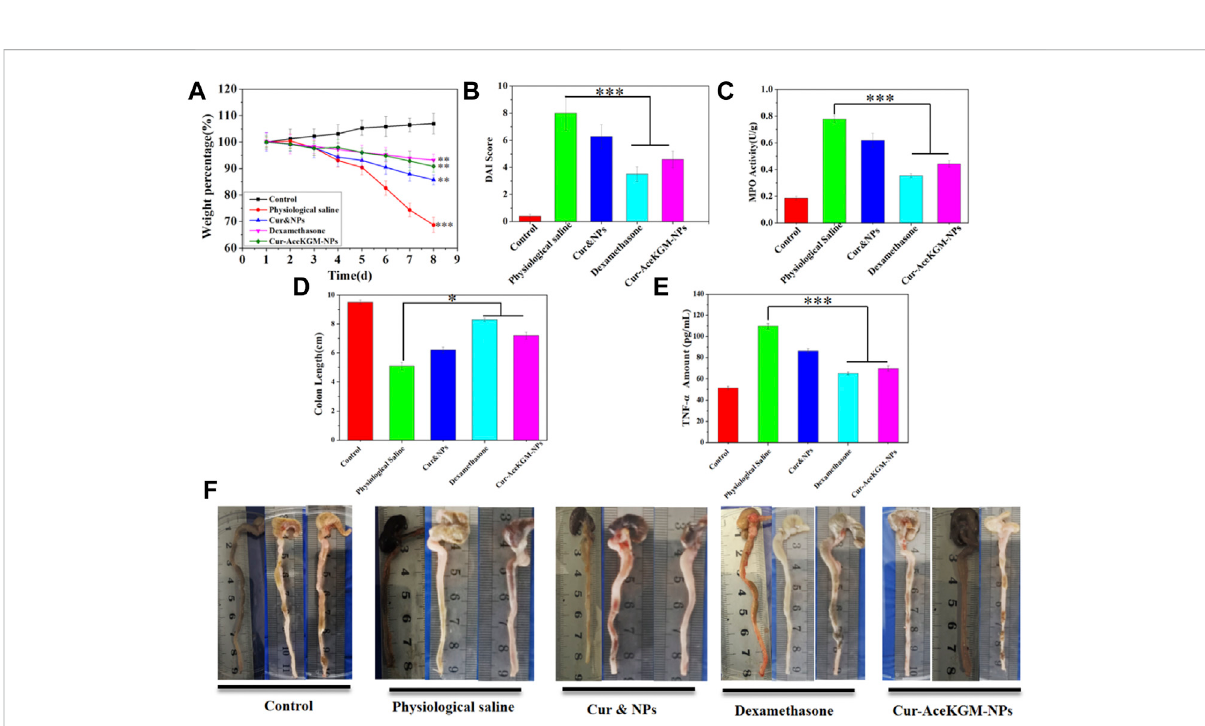
FIGURE 7 Therapeutic ef fi cacy of Cur – AceKGM NPs in mice with DSS-induced colitis. (A) Body weight percentage variation during the treatment with physiological saline, physical mixture of curcumin and AceKGM nanoparticles (Cur&NPs), dexamethasone, and Cur – AceKGM NPs; ** p < 0.01 and *** p < 0.001 versus the control group. (B) Disease activity index score. (C) MPO activity determination of the colon tissue. (D) Statistical analysis of colon length in different treatment groups, (E) colon tissue TNF- α amounts, measured by ELISA assays. (F) Gross view of the colon. All the experiments were performed in triplicate, and data are shown as mean ± SD. *** p < 0.001 and ** p <